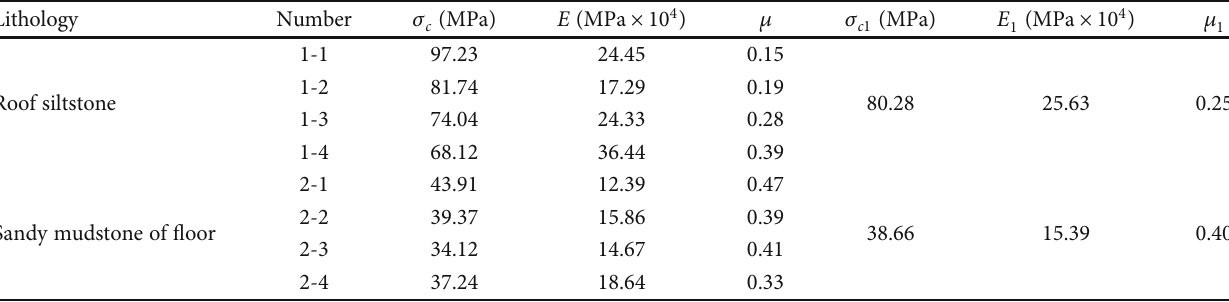
Table 5: Uniaxial compressive strength test